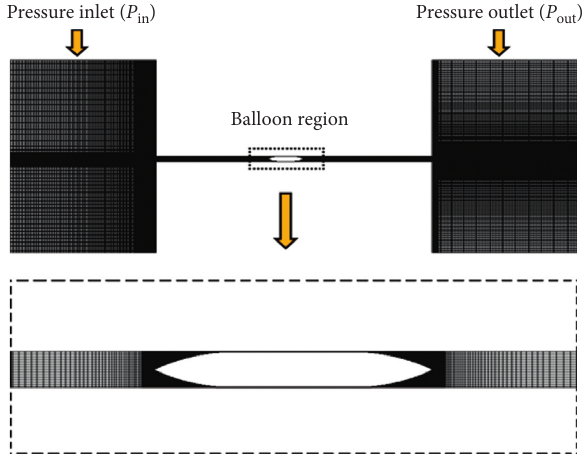
Figure 1: Computational mesh model.